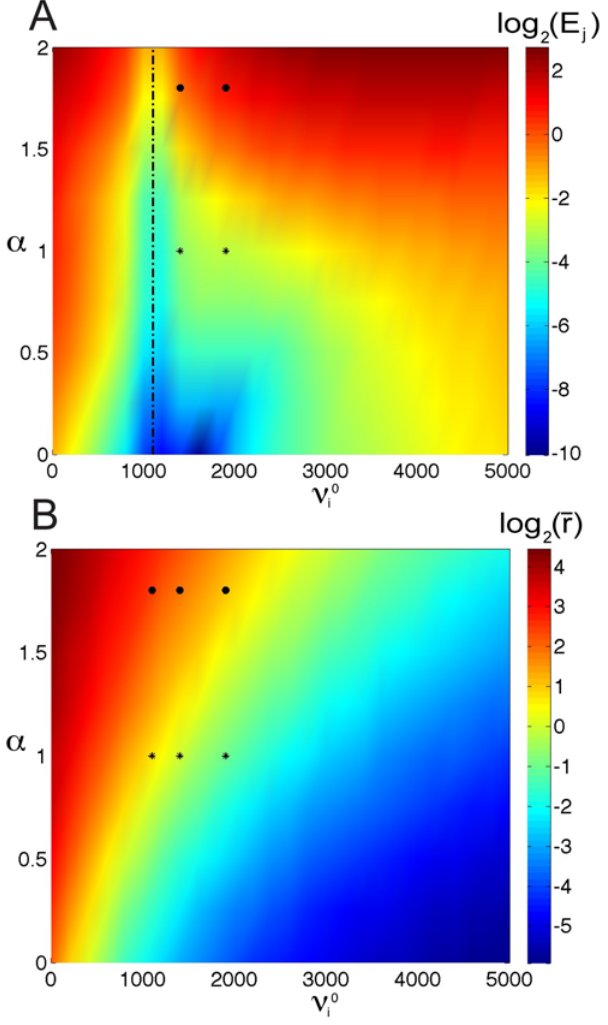
Figure 6. Parameter space where divisive gain modulation extends to the nonequilibrium regime. (A) The logarithm of the area (or error) between the time-dependent response curve r j t ð Þ and the r t ð Þ curve scaled by the equilibrium scale factor c eq j for many background levels and many driver inputs: